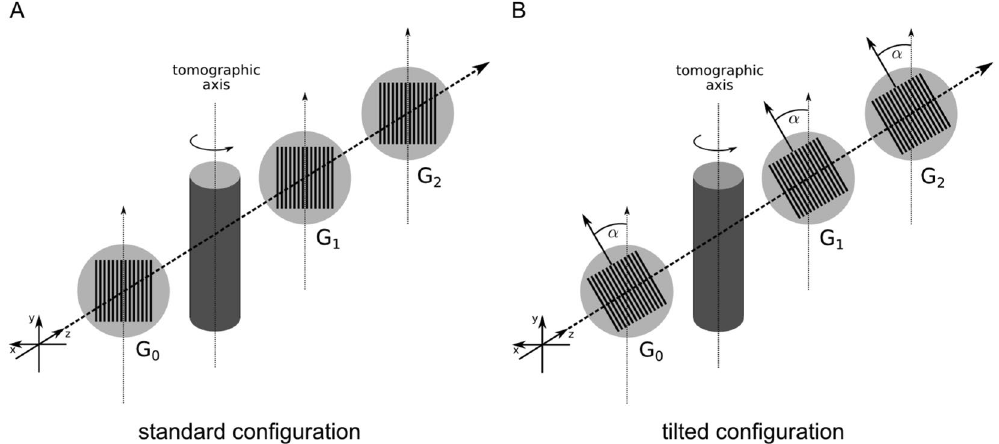
Figure 1. Schematic laboratory GBPC-CT set-up. Subfigure ( A ) shows the standard Talbot-Lau configuration using three gratings with grating lines in parallel to the tomographic axis. Subfigure ( B ) visualizes the tilted grating setup with a rotation of the grating line orientation by α = 45° with respect to the optical axis. The sample is indicated by the cylinder centered around the tomographic axis. G 0 is the source grating, G 1 the phase grating, and